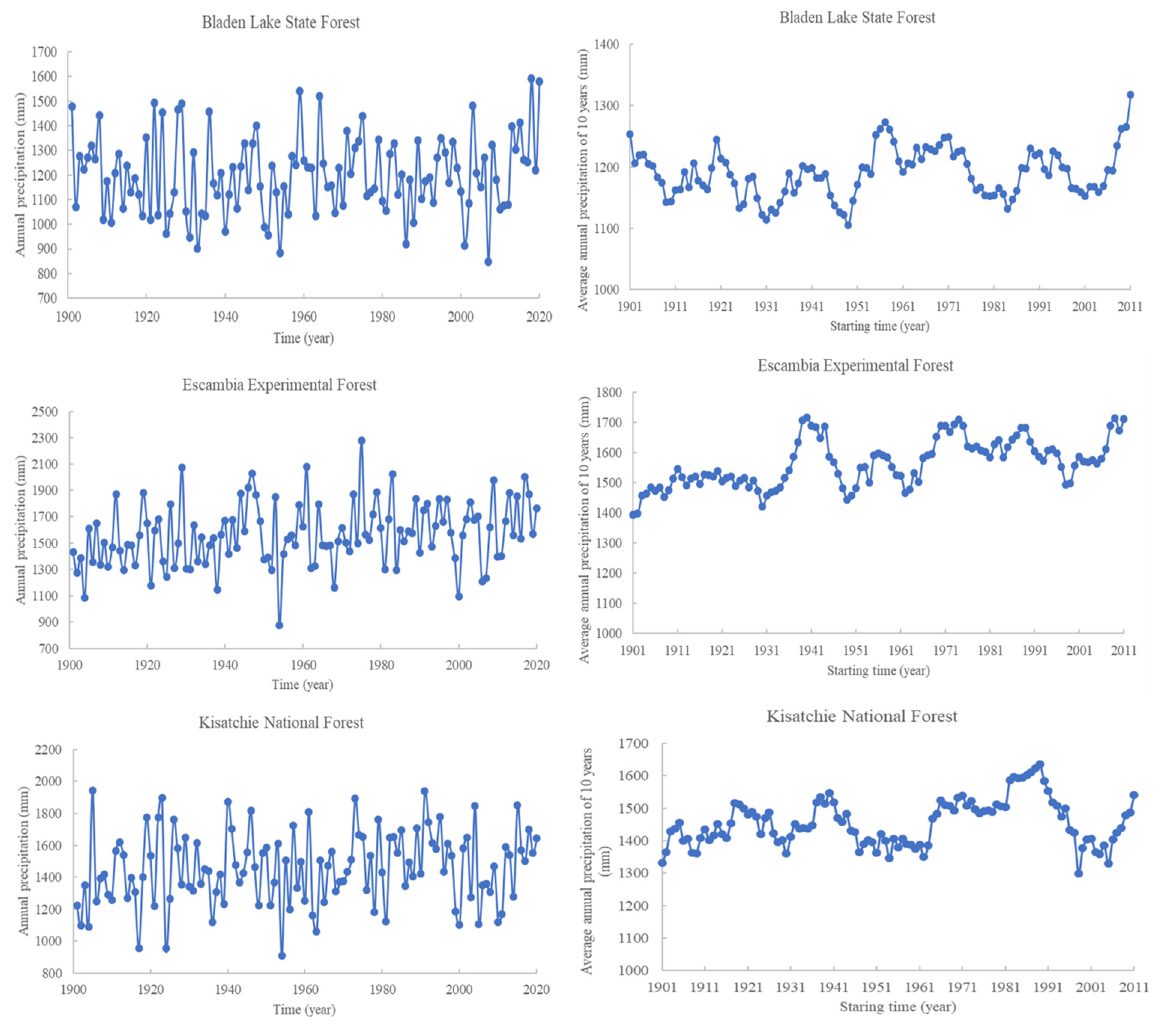
Figure 6. The dynamics of annual precipitation and the average of every 10 years at the 3 sites from 1901 to 2020.